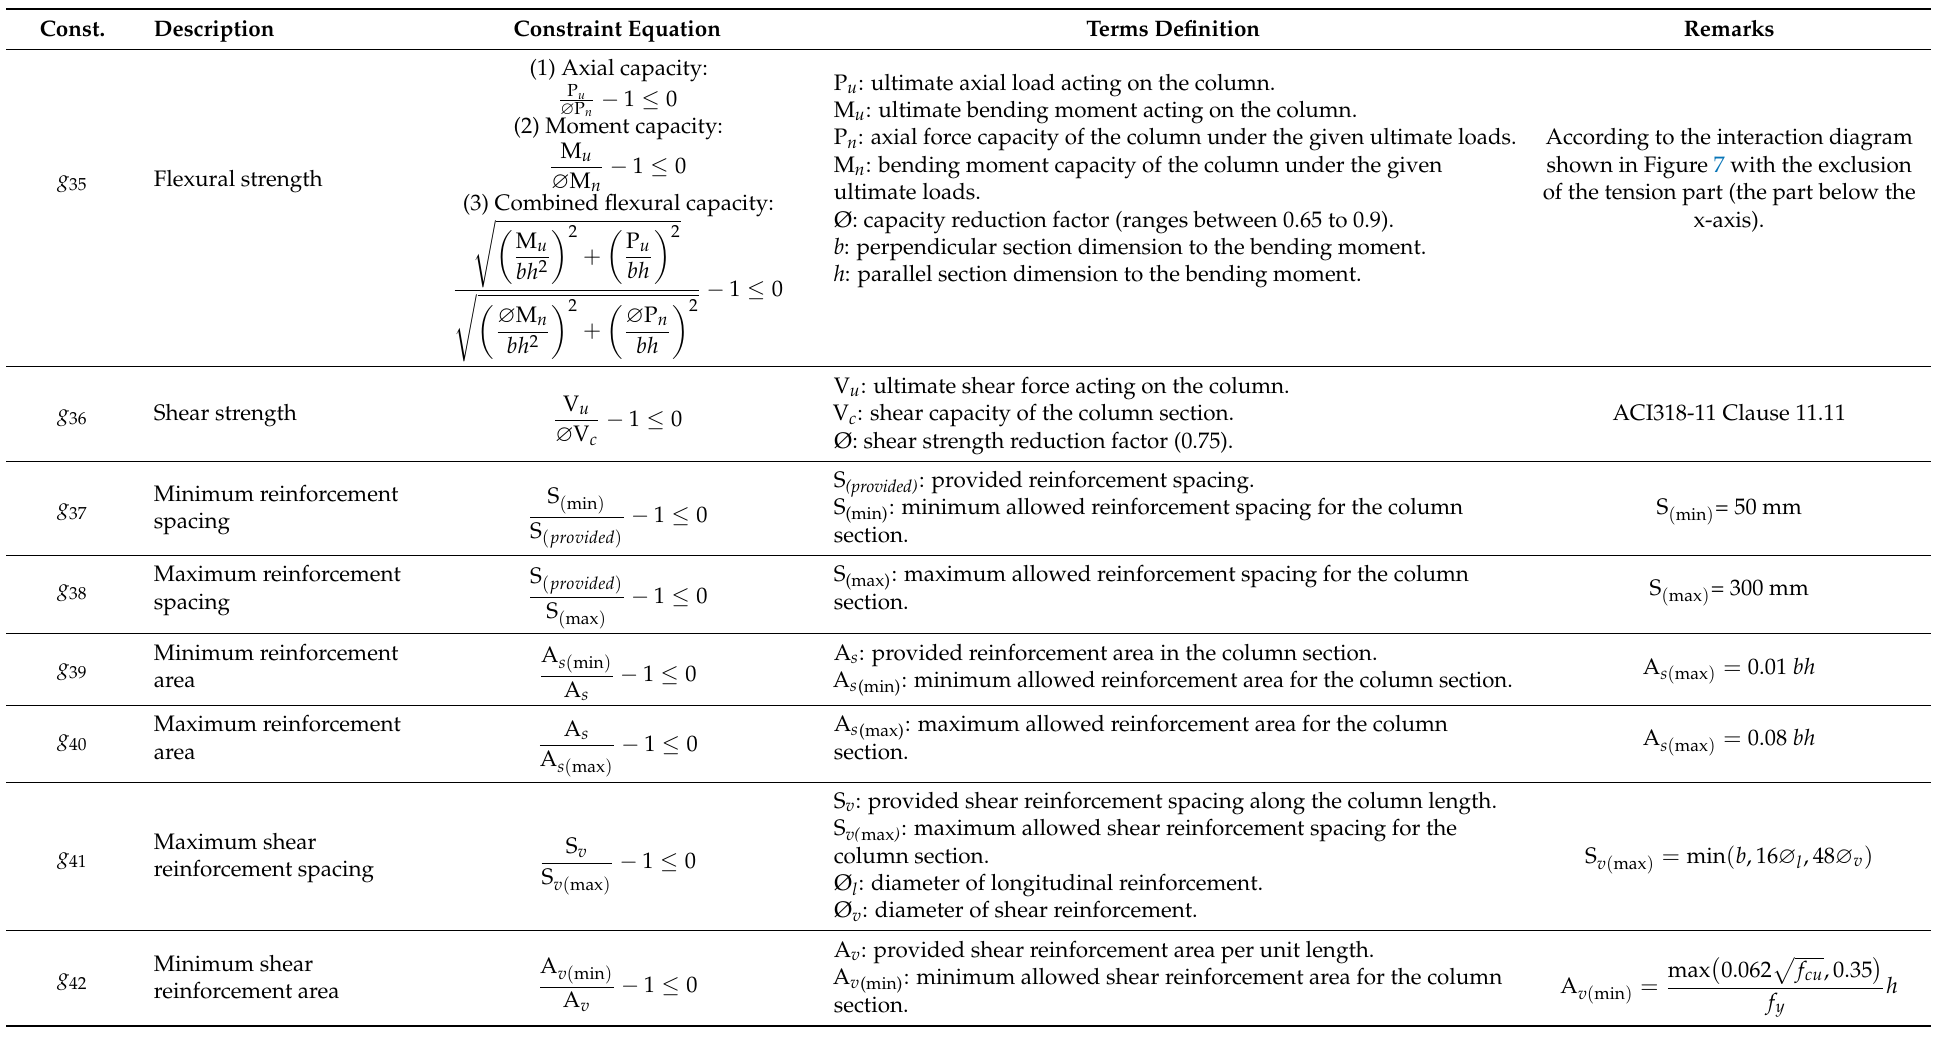
Table 9. Column’s constraints